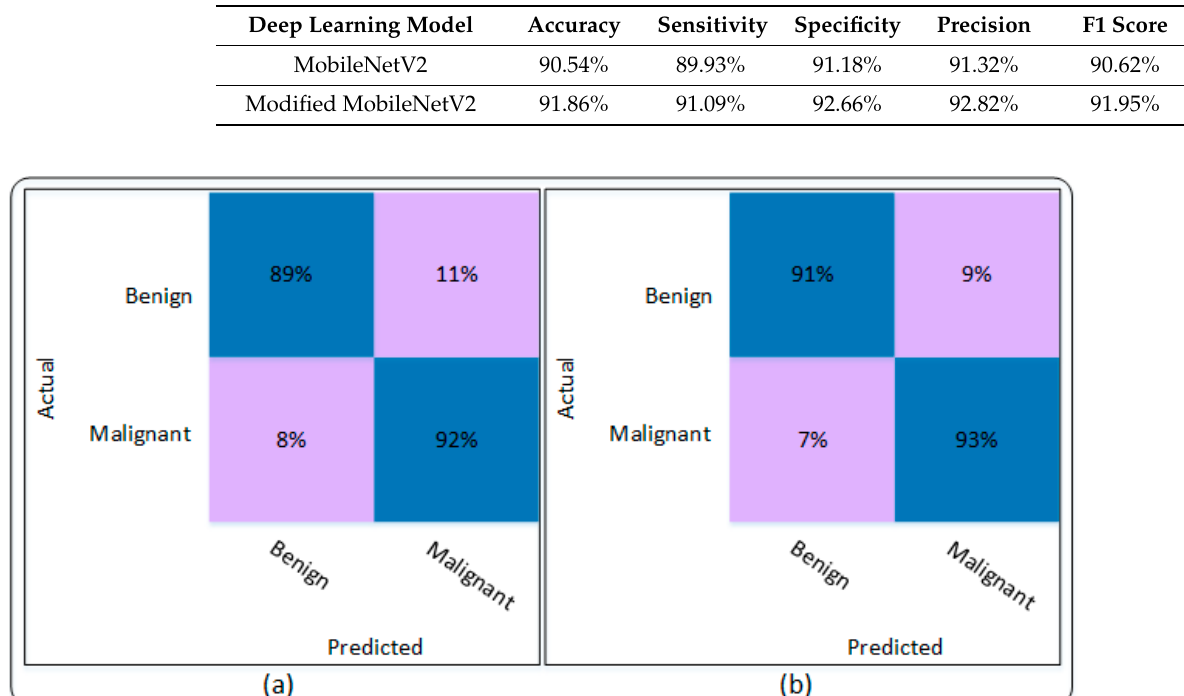
Figure 7. Confusion matrix of the proposed technique; ( a ) MobileNetV2 model, ( b ) Modified Mo- bileNetV2 model.